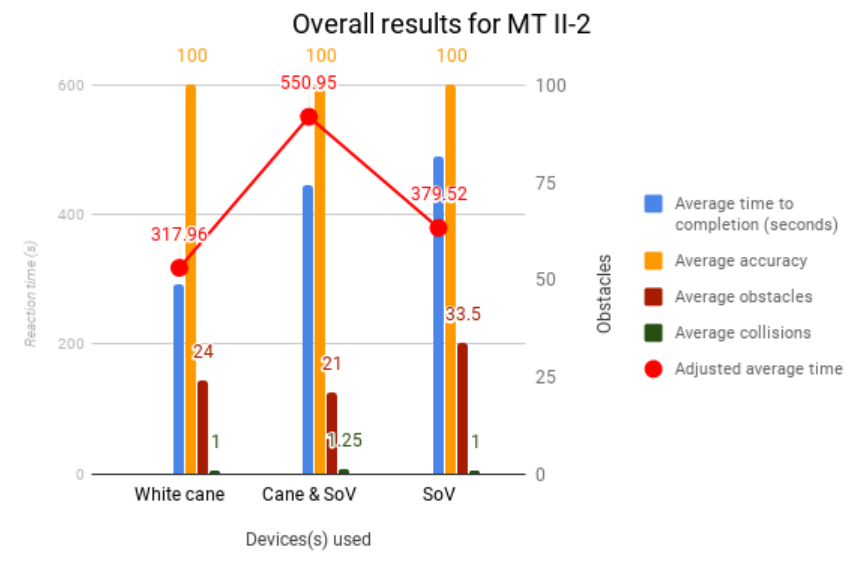
Figure 9. Average results over all users for the MT II-2 scenario (walking on the sidewalk) with the 3 modalities: SoV, white cane, SoV and white